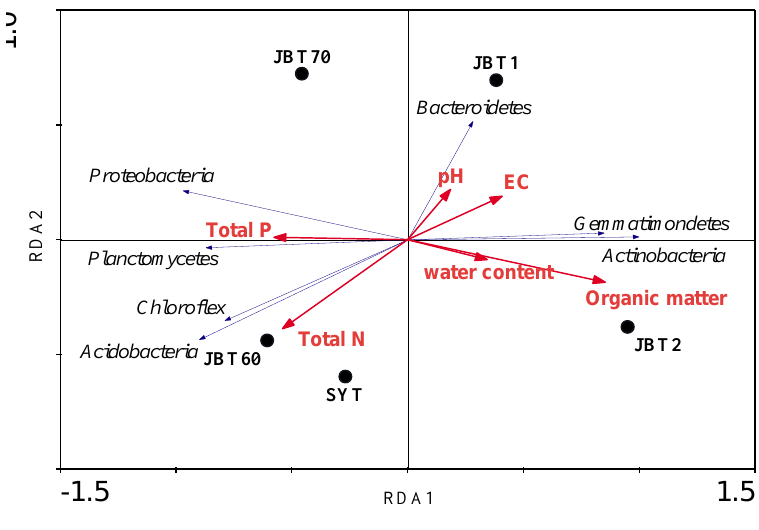
Figure 5. Redundancy analysis (RDA) of the relationship between the soil physicochemical parameters and the relative abundance of bacterial phylum of the five soil samples ( P < 0.05). Solid circles represent the soil sample. The abbreviation of samples is shown in Table 1. Arrows indicated the direction and magnitude of